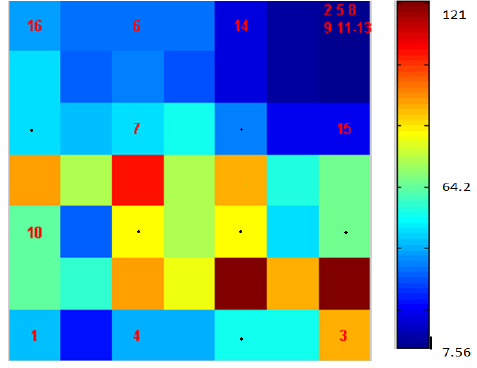
Figure 9. Criteria describing the insulation of walls on the SOM.